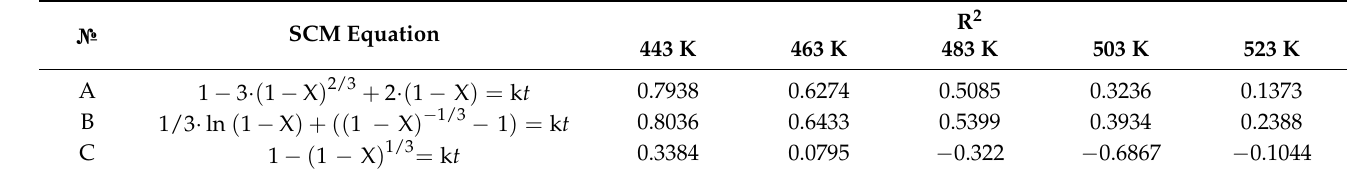
Table 5. SCM equation